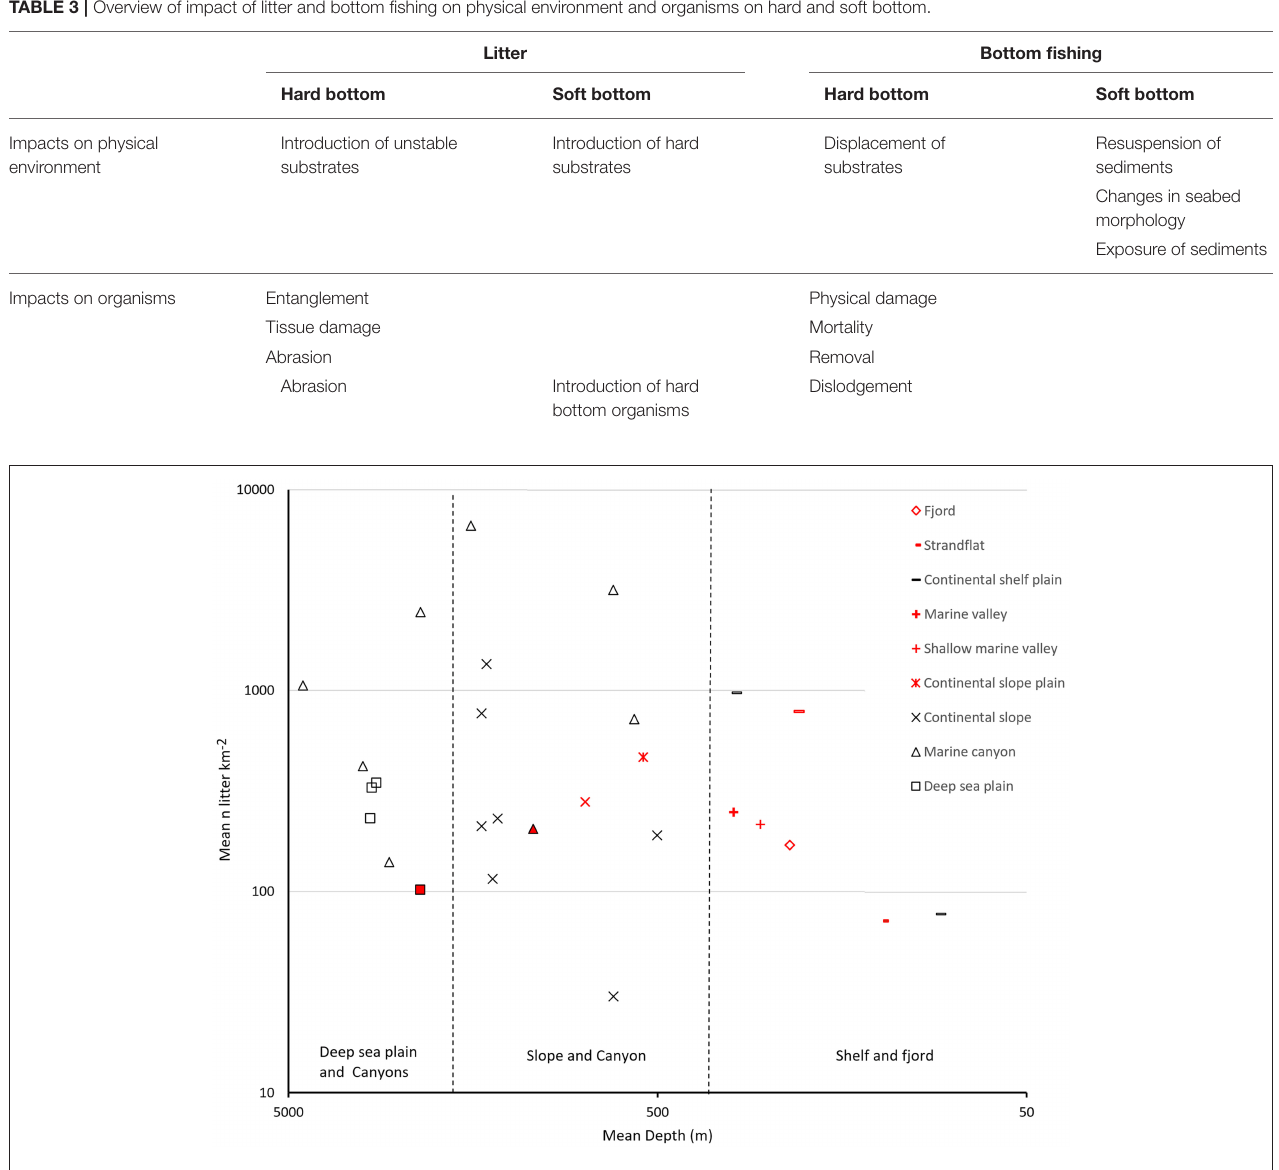
FIGURE 5 | Mean abundance of litter in different marine landscapes at different depth. Data from Pham et al. (2014) and (Buhl-Mortensen and Buhl-Mortensen,